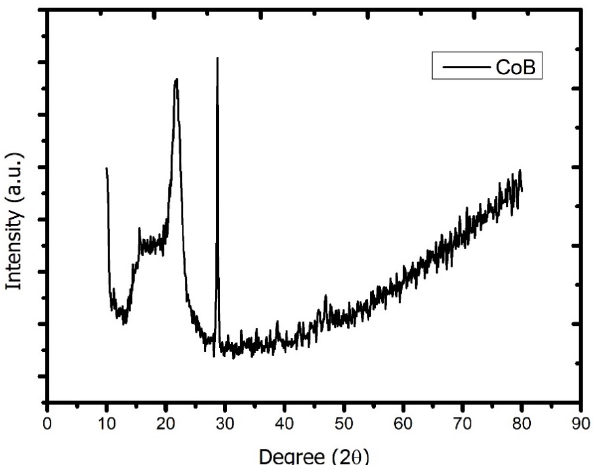
Figure 1. X-ray diffraction pattern of cobalt boride (Co 2 B) nanoparticles (Rigaku/Smart Lab diffrac- tometer with CuK α radiation ( λ = 0.154059 nm) operated at 40 kV and 30 mA).